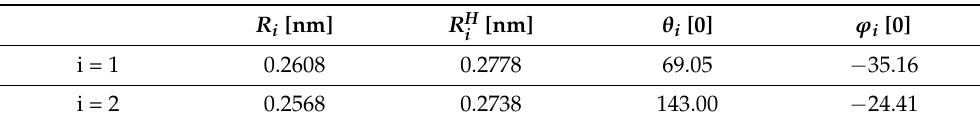
Table 2. The structural data for cerium dodecahedron [CeO 8 ] making of two tetrahedrons in the BaWO 4 single crystal [13,29].